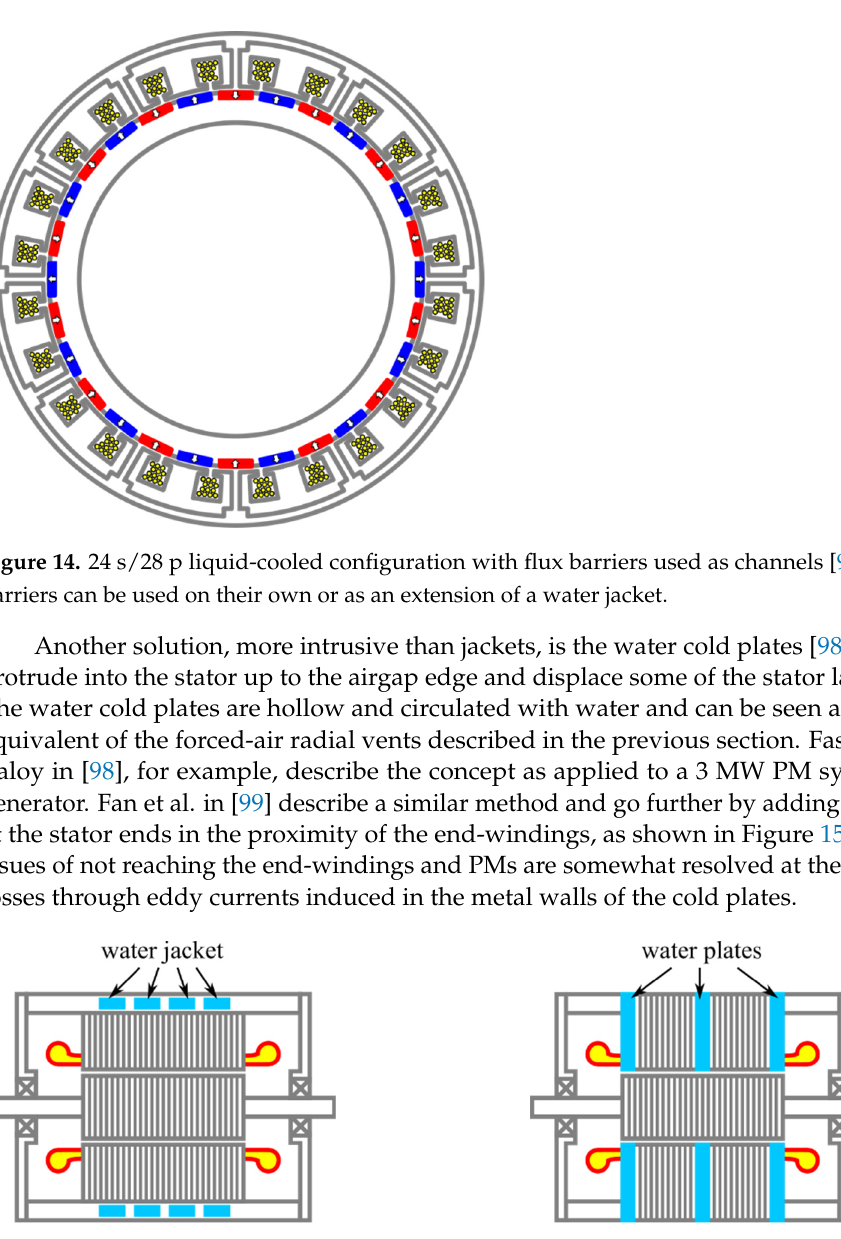
( d ) Figure 13. Various jacket configurations [95]: ( a ) circumferential structure; ( b ) helical structure; ( c ) half-helical structure; ( d ) axial structure. The liquid jackets are a non-intrusive way of cooling a generator, being located away from problematic regions where they could displace active materials or introduce para- sitic effects such as eddy currents induced in metal liquid pipes. They are also the most maintainable of the liquid methods, as the cooling pipes are located in an accessible area and can be inspected or replaced due to fouling. The liquid cooling jacket is relatively far away from the end-windings, with the consequence that the windings hotspot will move from the slot into the end-windings. Most importantly, the liquid jackets are positioned much further away from the PMs across the airgap and can fail to keep the PMs’ temper- ature below the demagnetization value. The direct-drive machines for wind power appli- cation stand out due to their low speed, which in turn ensures lower heat transfer between the rotor and the stator (due to laminar or low turbulence airflow in the airgap [31,79]). Due to the application type, it is not possible to increase the rotor speed. Slightly modified versions of liquid jacket methods protrude into the generator until the airgap. In Figure 14 [93], for example, a water jacket that extends into the existing flux barriers is described.